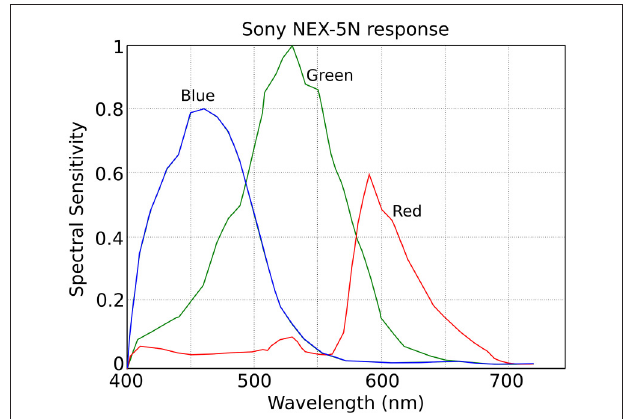
FIGURE 1 | Spectral sensitivity of Sony NEX-5N digital camera (adapted from Jiang et al., 2013).